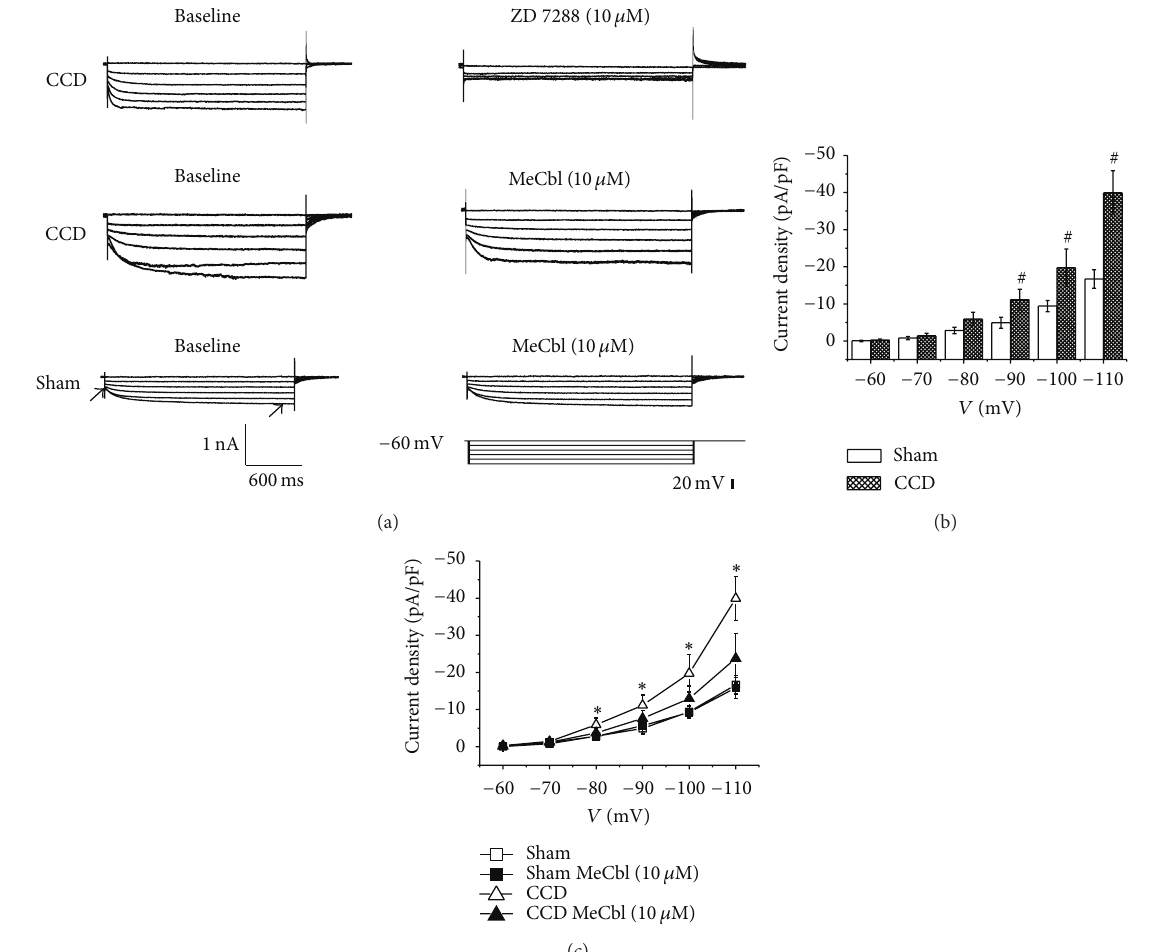
Figure 6: MeCbl inhibited the 𝐼 ℎ of medium-sized neurons of DRG neurons. (a) 𝐼 ℎ current is evoked by hyperpolarizing voltage steps from a holding potential of − 60 mV. 𝐼 ℎ current amplitude is calculated from the difference between the steady-state and the instantaneous current. (b) Increased 𝐼 ℎ current density of medium-sized DRG neurons in CCD rats. # 𝑃 < 0.05 , compared with those of sham group. (c) Effects of MeCbl on the 𝐼 ℎ current density of medium-sized DRG neurons. ∗ 𝑃 < 0.05 , compared with those in the absence of MeCbl.